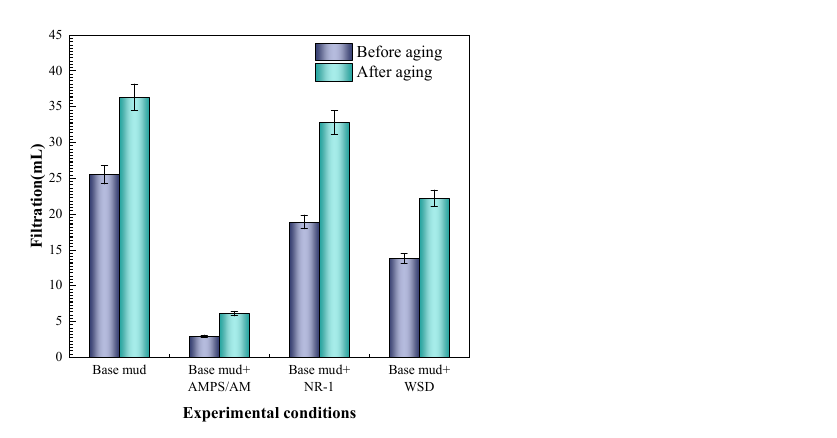
Figure 3. Comparison of the filter loss reduction performance of three blocking agents in base mud.